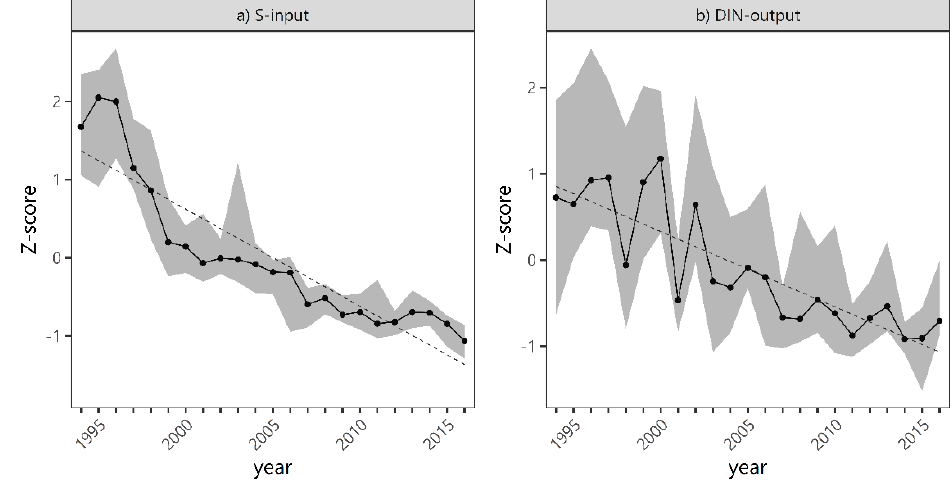
Figure 3. Long-term trends observed in ( a ) sulfur deposition and ( b ) stream water total dissolved inorganic nitrogen export as normalized z-scores computed from all catchments. Bold lines show median values for all sites, gray-shaded areas show variations between catchments (10th and 90th percentiles), and dashed lines show the linear